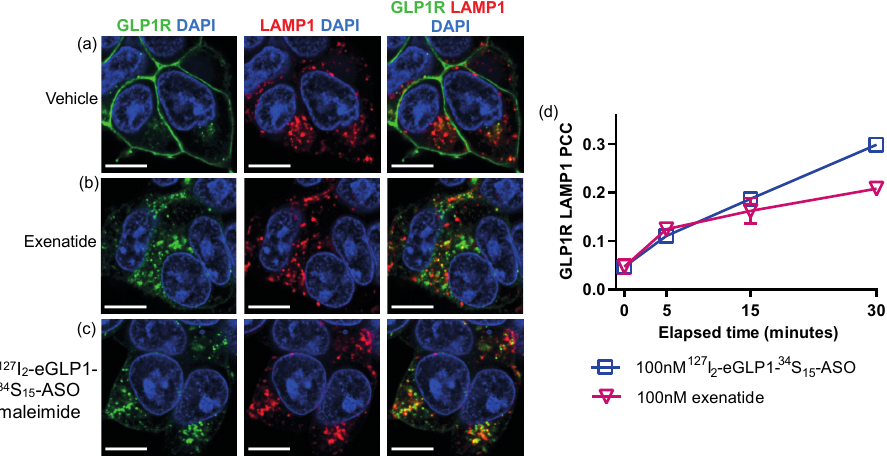
Figure 6. Representative confocal images of GLP1R and LAMP1 following 30 min incubation with vehicle control ( a ), 100 nM exenatide ( b ), or 100 nM 127 I 2 -eGLP1- 34 S 15 -ASO ( c ). Nuclei were counterstained with DAPI. Nuclei were counterstained with DAPI. Pearson’s correlation co-efficient for GLP1R colocalization with LAMP1 was calculated from cytoplasmic ROIs ( d ). All analyses are presented as mean ± SEM for 3 independent experiments. For each condition, cells from at least 10 fields of view were analyzed from at least 2 technical replicates per experiment. Scale bar = 10 μ m.